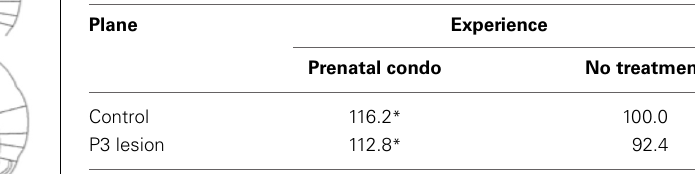
Table 5 | Summary of thalamic area in the posterior